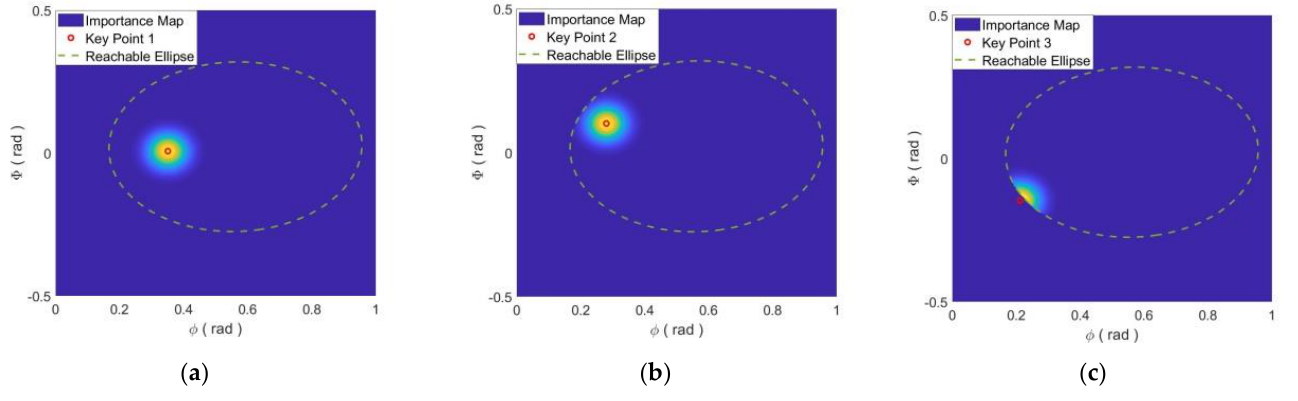
Figure 8. Relative Importance calculation: (a) is the mapping area key point 1; (b) is the mapping area of key point 2; and (c) is the mapping area of key point 3.